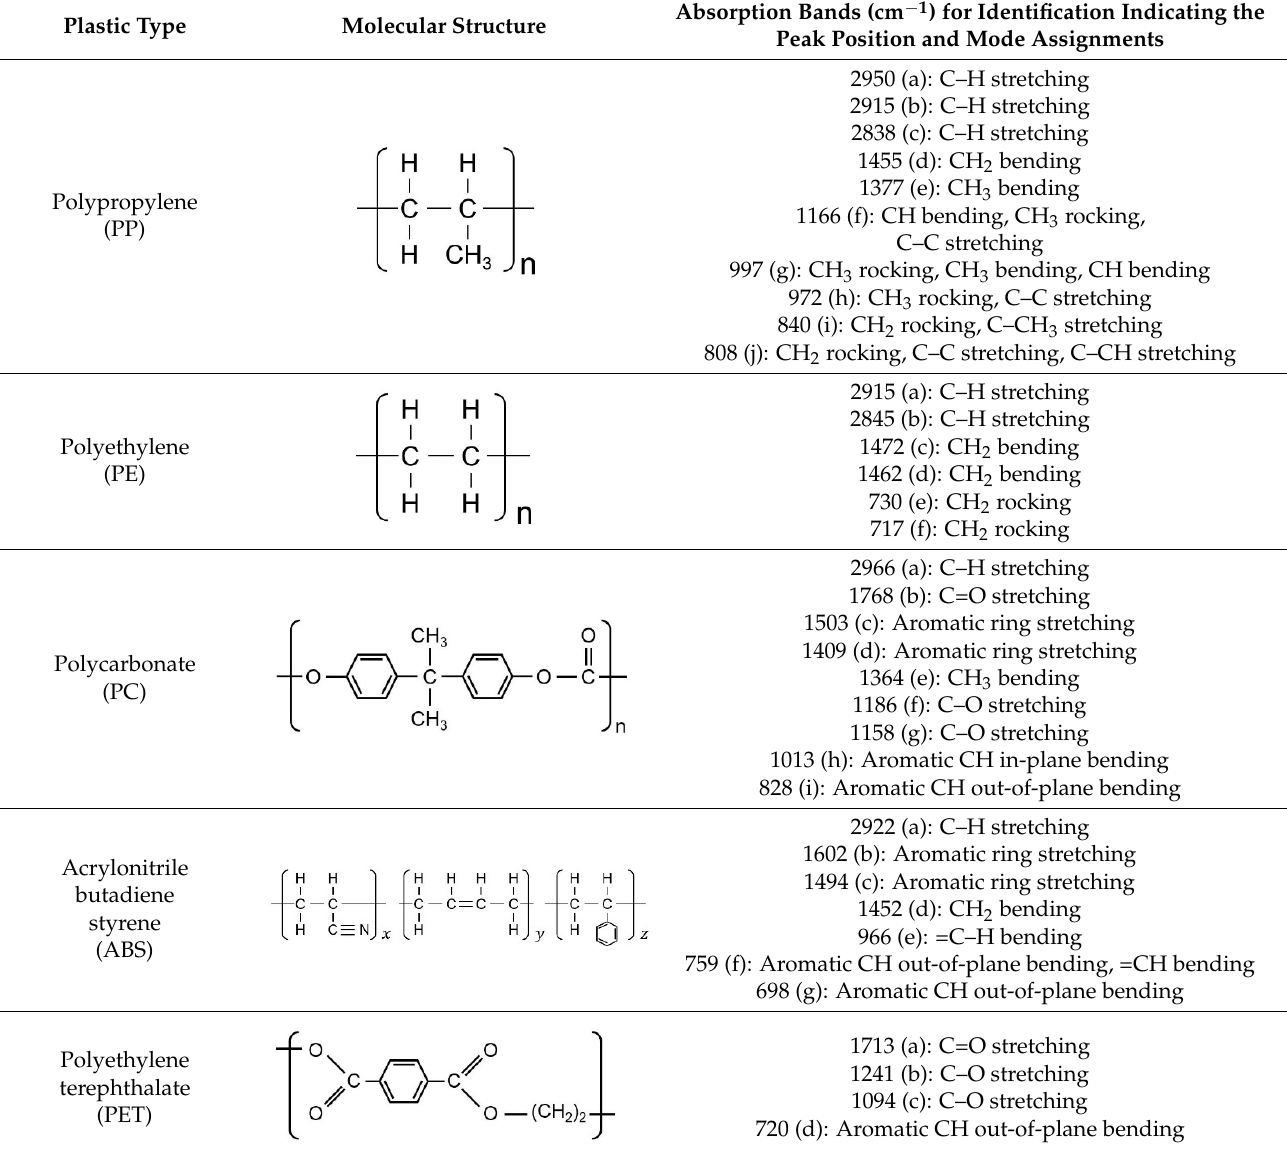
Figure 14. FT-IR spectra of polypropylene (PP) aggregate with different irradiation doses. As a result of the FT-IR analysis of the PP aggregate, from Figure 14, in the FT-IR spectrum of neat PP, the peaks observed near 1166 and 977 cm − 1 confirm that the PP used in the present case is isotactic. It is observed that the intensity of these peaks continuously decreases with the increase in gamma irradiation dose, and this indicates that these bonds are the result of chain scission by gamma radiation. Furthermore, new characteristic bands at 1650 cm − 1 appear at all the gamma dose levels . Th ese correspond to the carbonyl C=O groups, and the appearance of the C=O group indicates oxidation. This is because the C- H and C-C bonds of PP are the result of scission and consequently the formation of free radicals and ionized species. The reaction of free radicals with oxygen does not allow the polymer chains to crosslink, which leads to chain scission predominating over crosslinking in